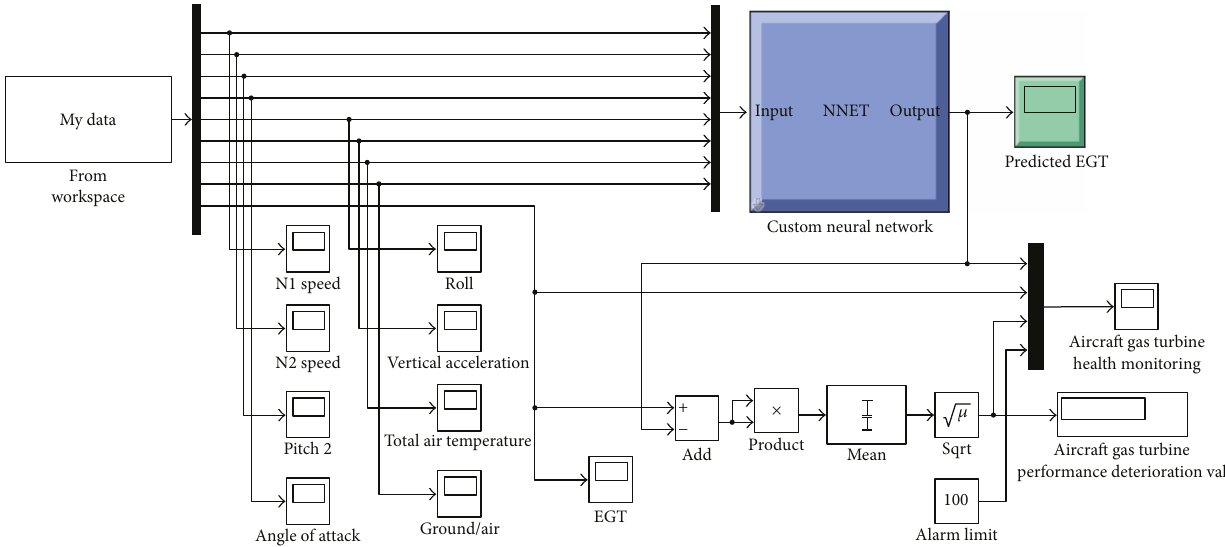
Figure 10: Aircraft gas turbine engine health monitoring